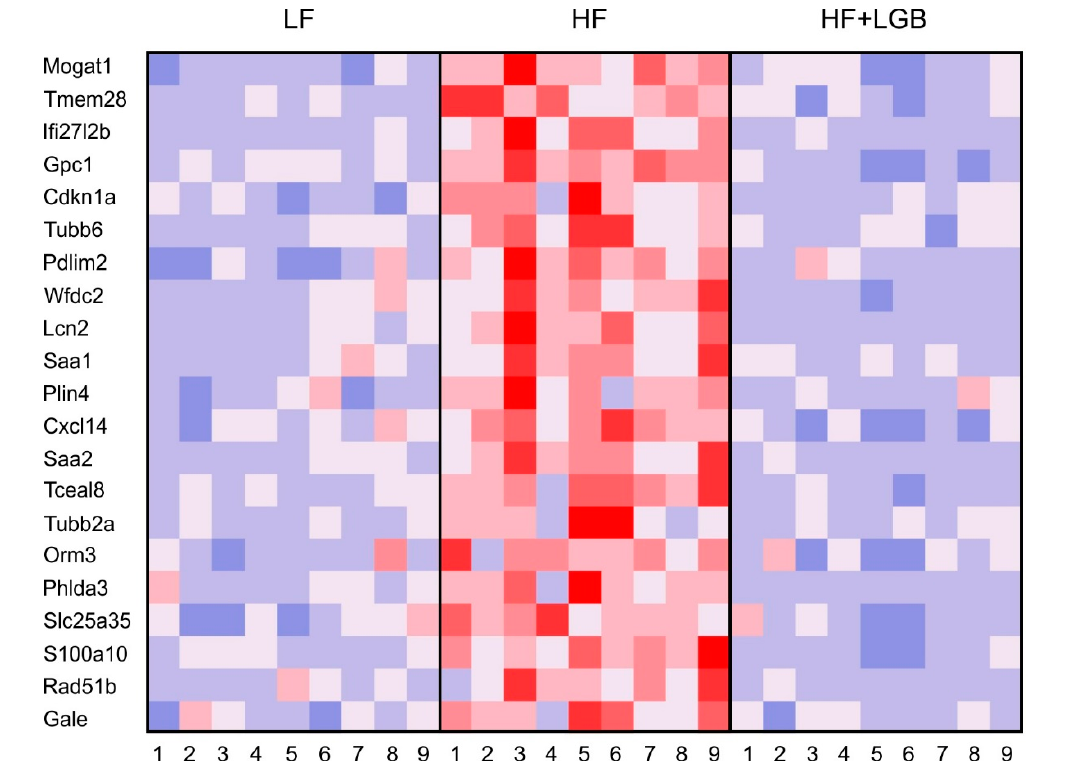
Figure 3 . A heatmap of the genes upregulated by the HF diet (with an average fold change > 1.5 as compared with LF diet group) and whose increase was prevented by the HF + LGB diet (with an average fold change < − 1.5 as compared with HF diet group). Gene expression levels are DESeq2-normalized and row-scaled; red color: higher expression; blue color: lower expression. N = 9 mice per group as indicated with the numbers on the horizontal axis.